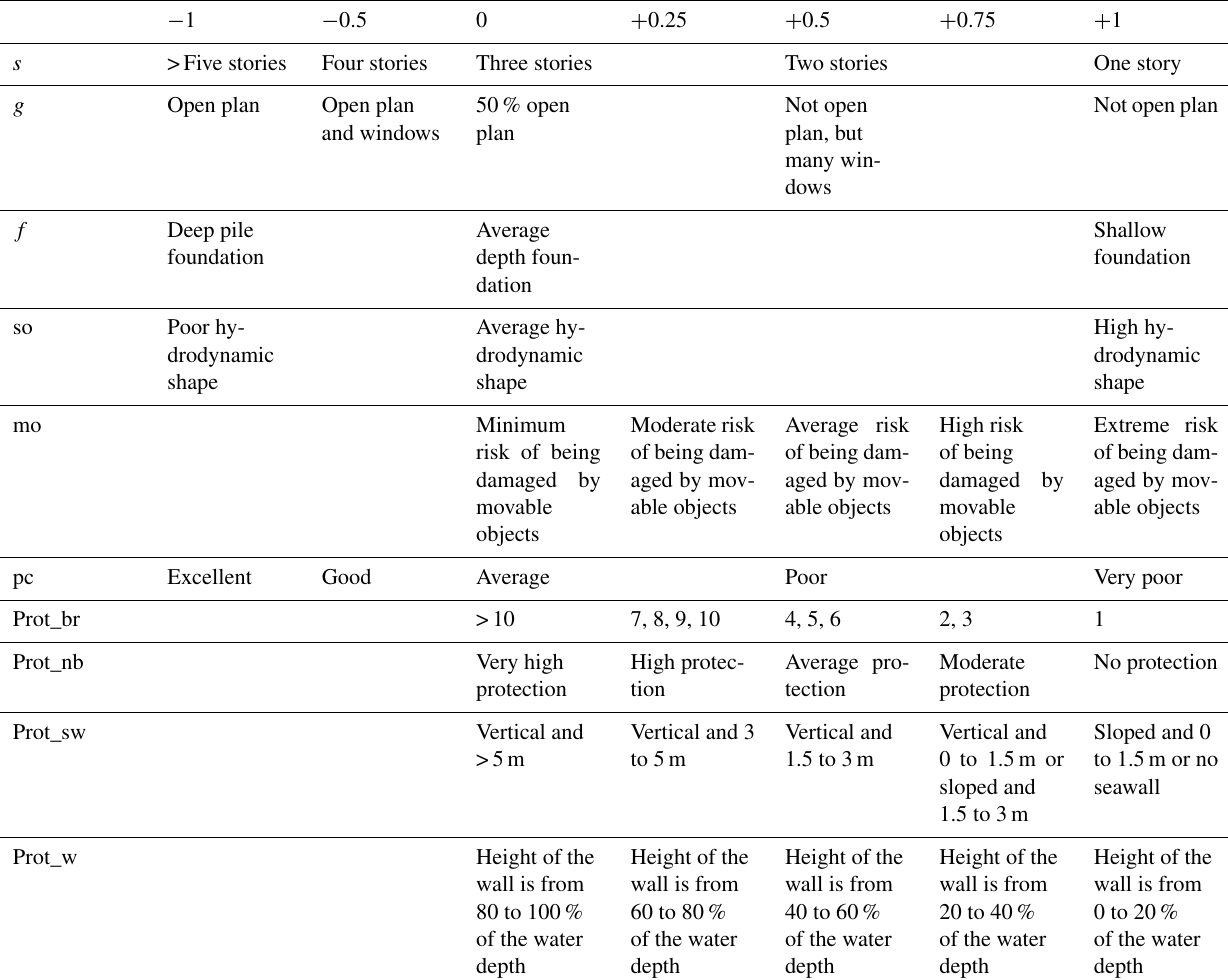
Table 1. Attributes and their values influencing the structural vulnerability of a building (Bv) and its level of protection (Prot) in PTVA-3 model (Dall’Osso et al.,